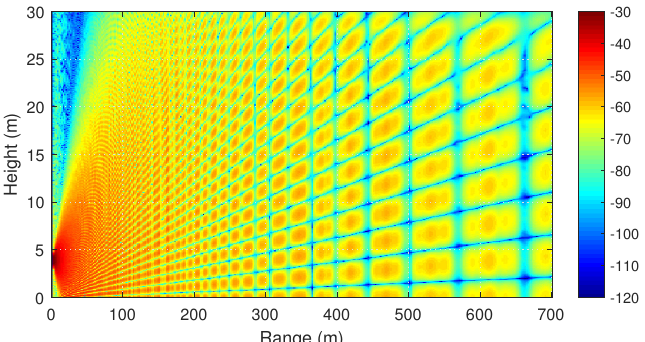
Figure 6. Propagation in a street canyon. Two-dimensional distribution of the signal level (dBm) along the x axis, calculated by the PE method.